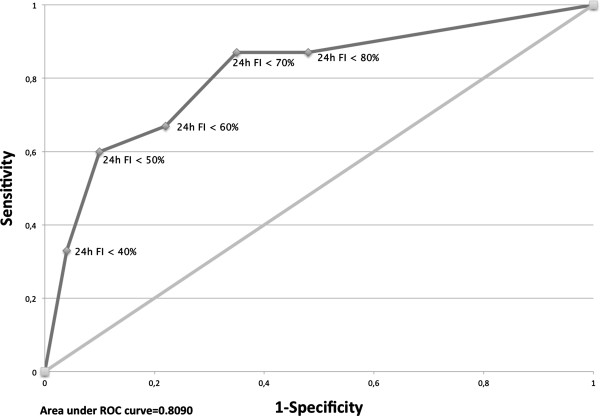
Roc curve : Compromise sensibility / specificity for different values of 24h FI.